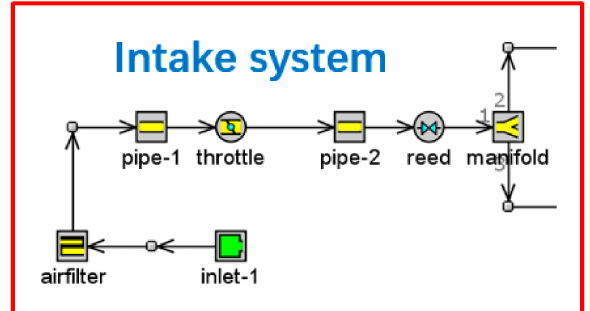
Figure 11. The layout of intake system in